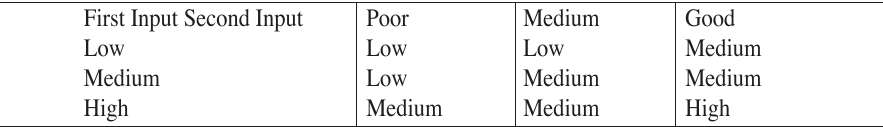
Fuzzy rule base matrix for the first stage